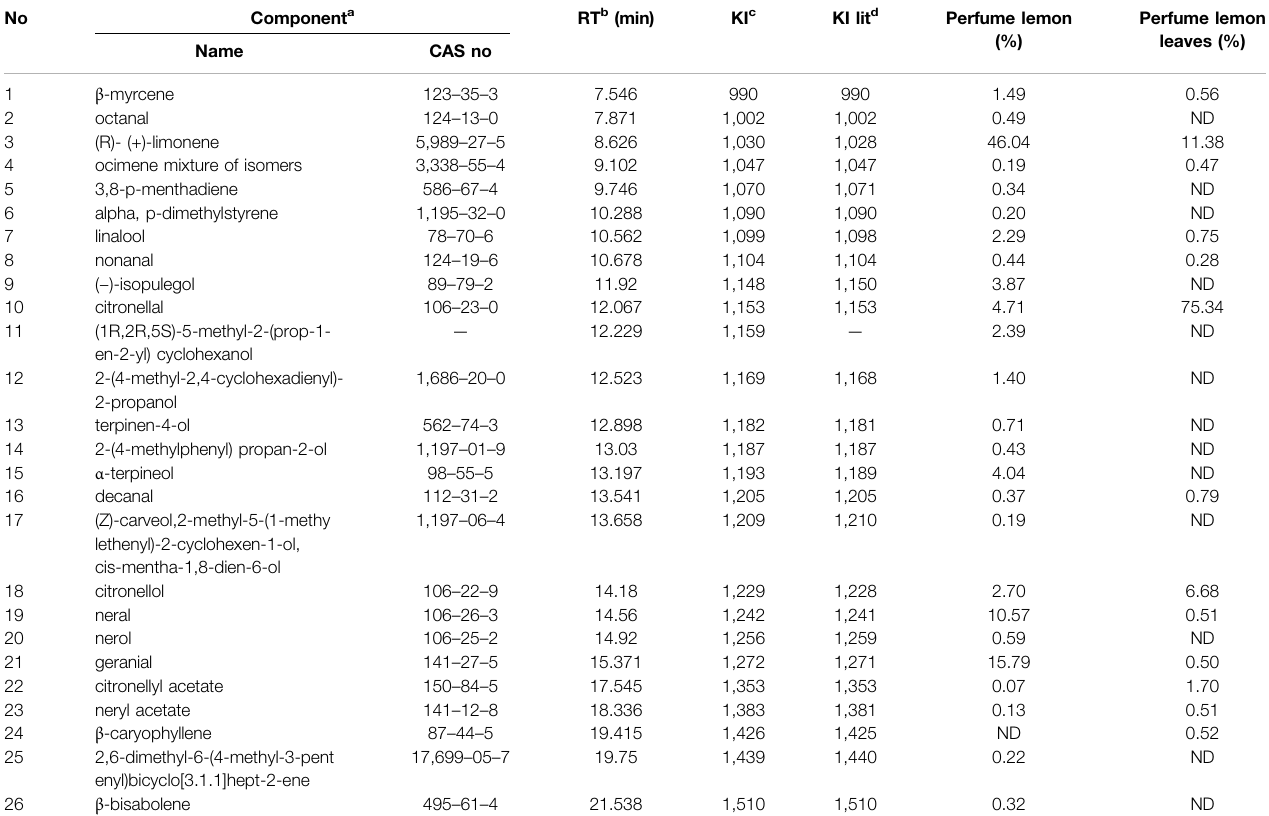
TABLE 1 | Chemical compositions of fresh perfume lemon and leaves essential oils.